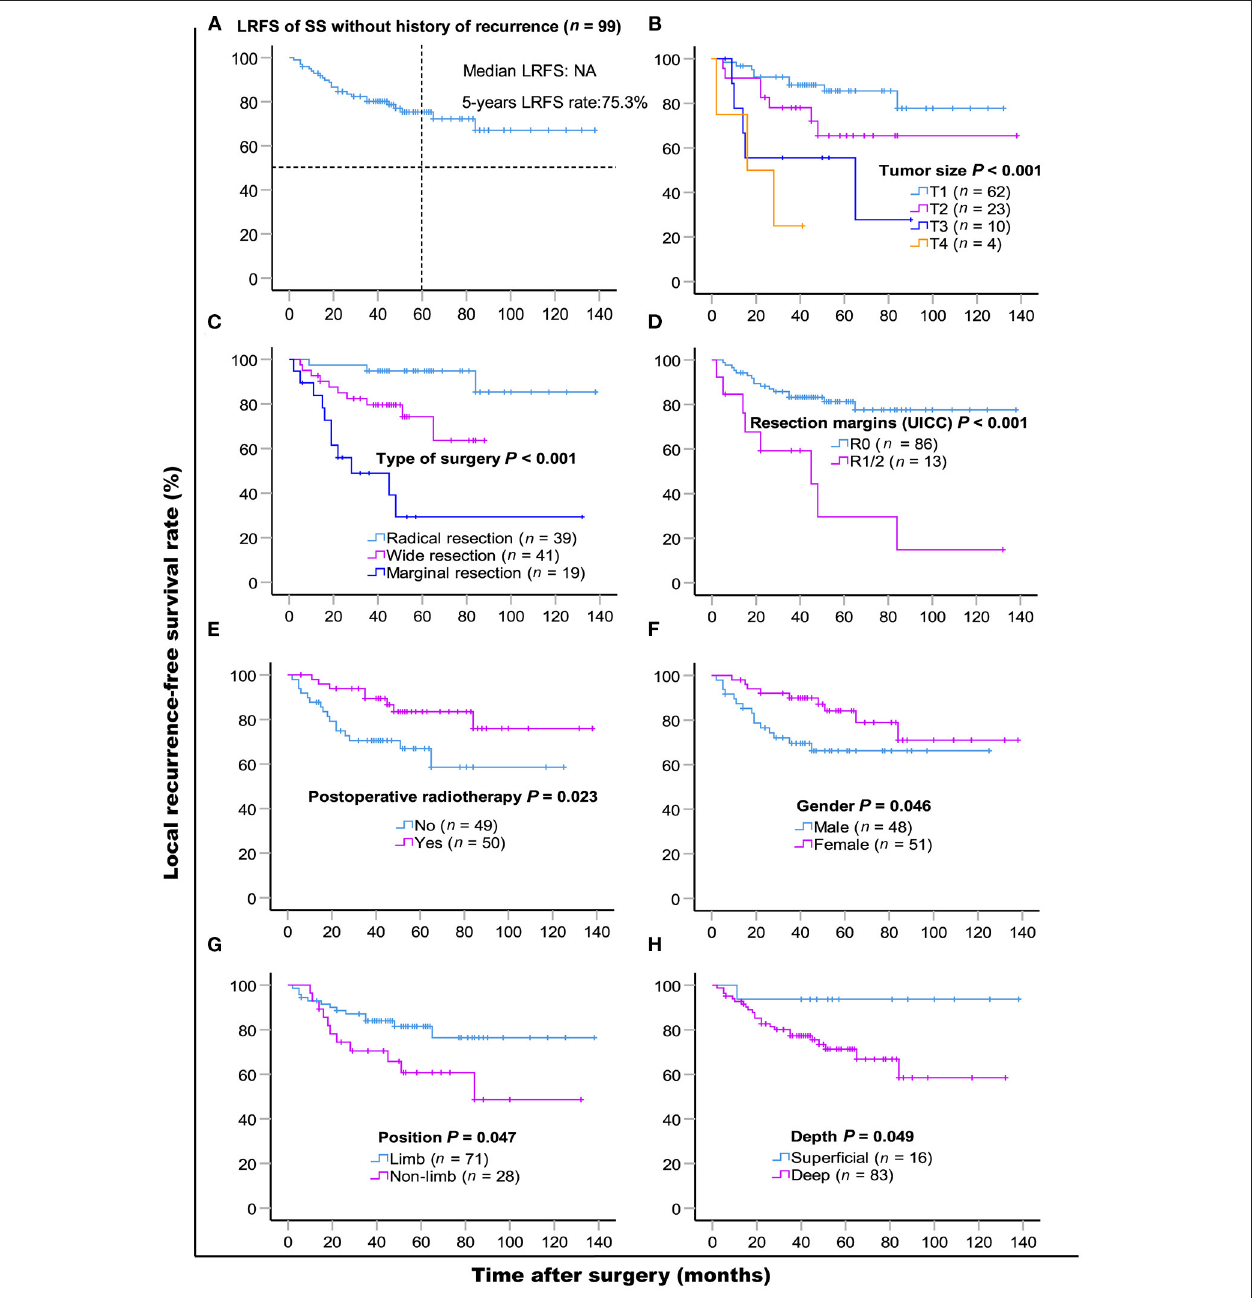
FIGURE 2 | Kaplan-Meier local recurrence-free survival curves of 99 patients without history of recurrence (A) and compared according to (B) tumor size, (C) type of surgery, (D) resection margins (UICC), (E) post-operative radiotherapy, (F) gender, (G) position, (H) depth. Log-rank test was used to compare curves, number of patients in subgroup ( n ) and significance ( P ) are shown on